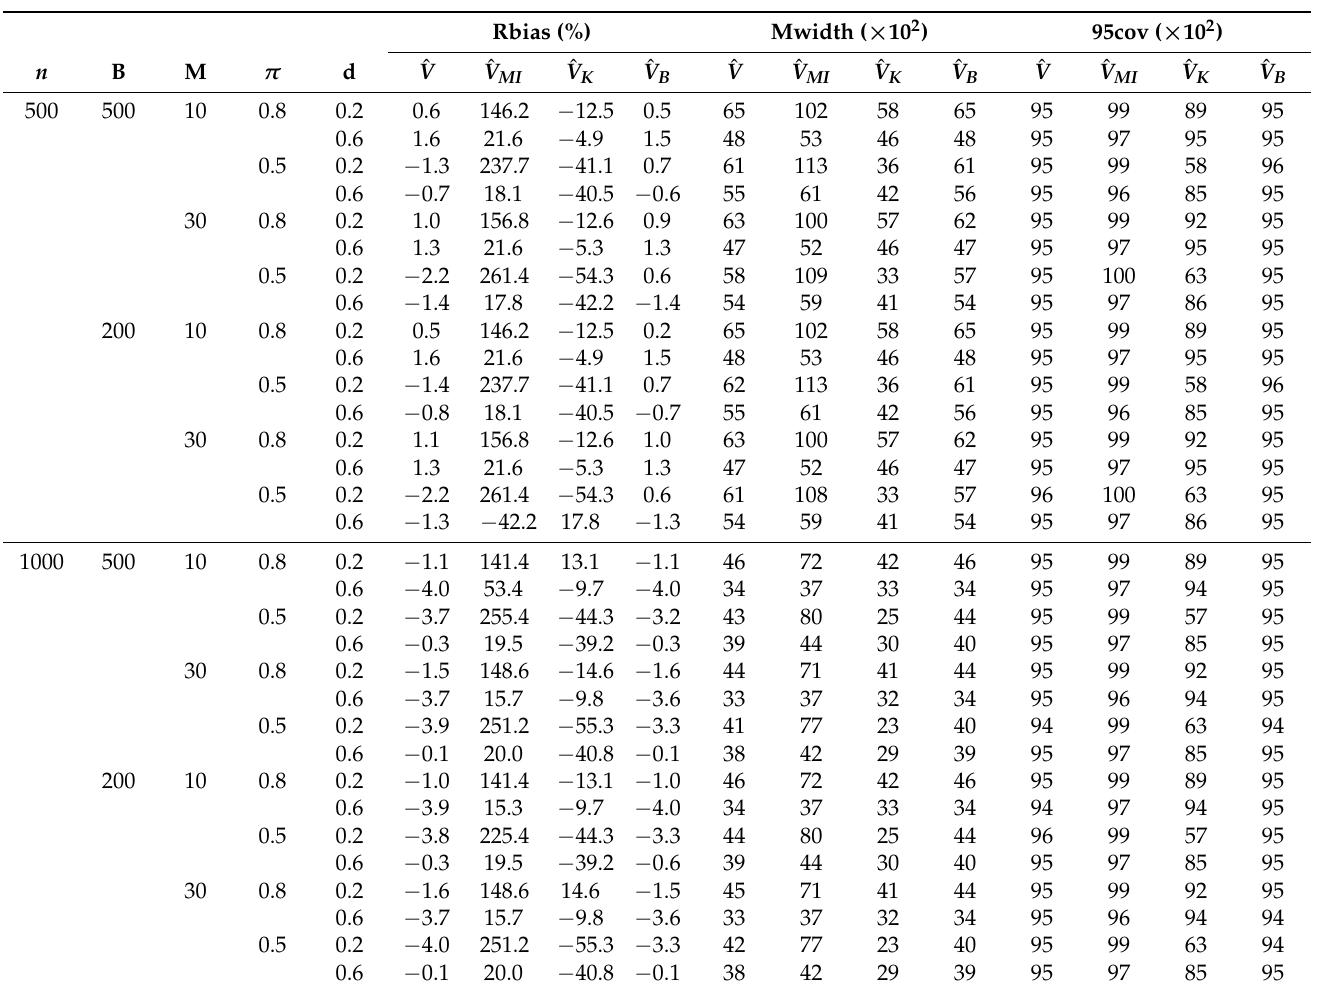
Table 1. Simulation results for the domain mean